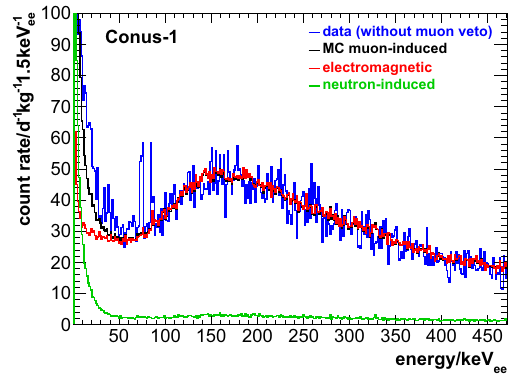
Fig. 6 Comparison of μ -induced background in the GIOVE (black) setup to the spectrum detected with the CONRAD detector within the CONUS shield (red). For GIOVE, the innermost layer is composed of Cu, while for the CONUS shield the material is Pb. This leads to an improved suppression of the bremsstrahlung continuum below 500keV ee . Figure previously published in [20]